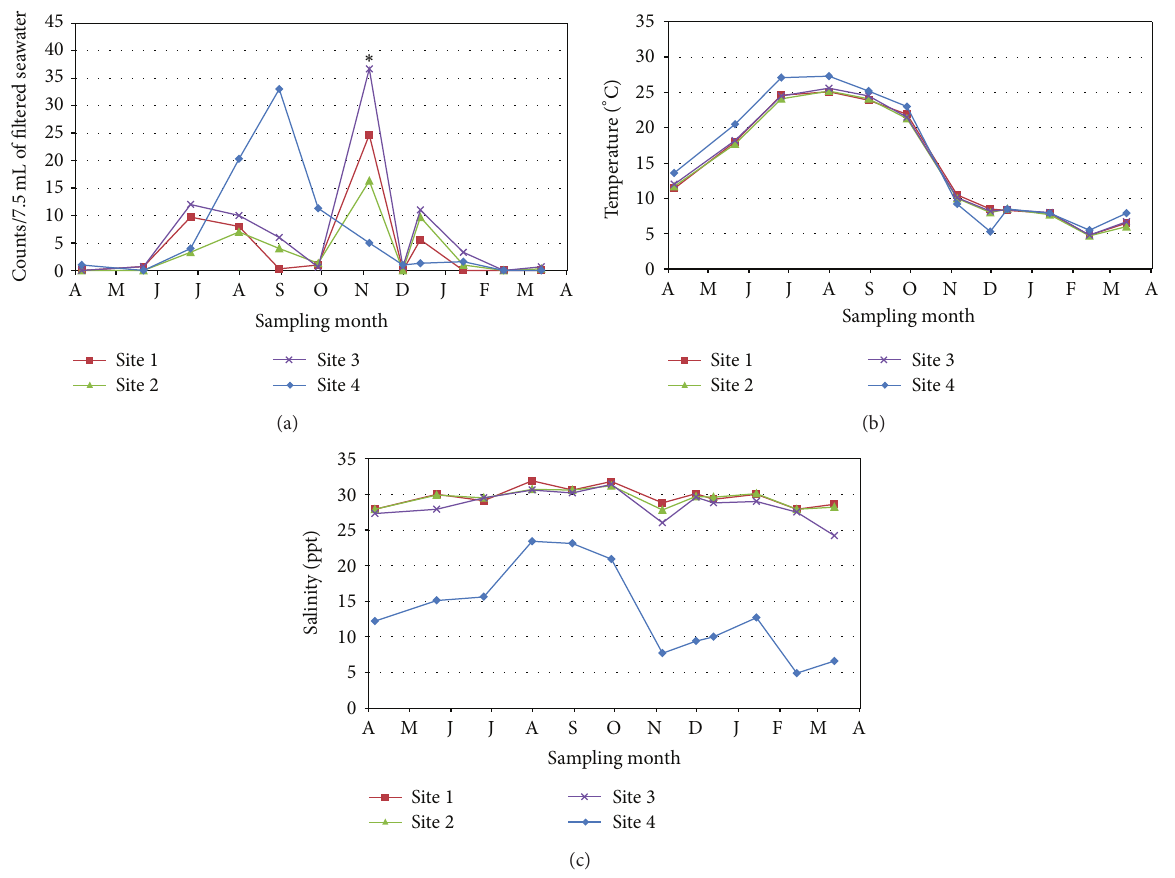
Figure 2: Monthly Bacteriovorax levels and water parameters at four Delaware sites over 1 year. (a) Bacteriovorax levels/7.5 mL seawater, (b) seawater temperature, and (c) seawater salinity. Bacteriovorax levels are the mean of three separate analyses for each site. The asterisk in (a) signifies Bacteriovorax counts from a sample collected 1 week after a major hurricane.